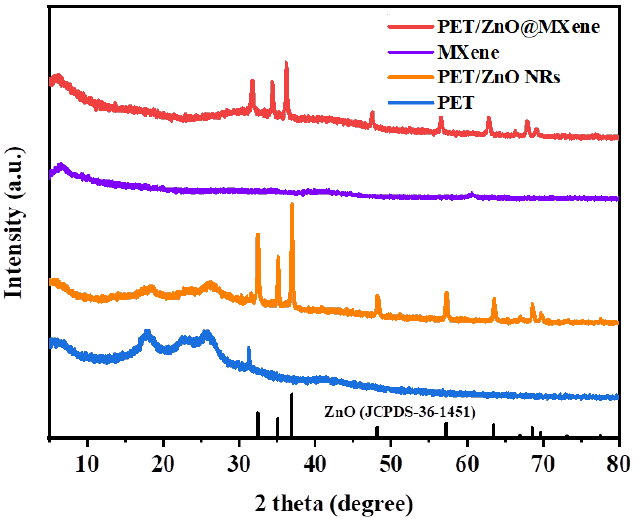
Figure 2. XRD patterns of PET, MXene, PET/ZnO NRs, and PET/ZnO@MXene composite fabrics.